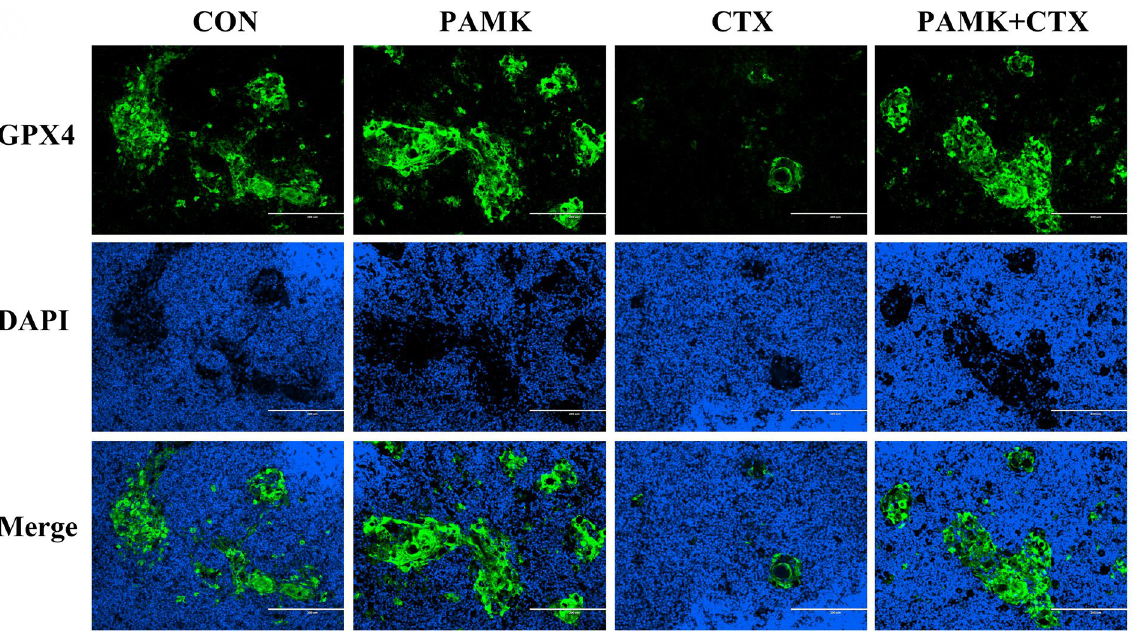
Figure 4. Effects of PAMK on the protein expression of GPX4 in thymus treated with CTX. Images of immunofluorescence staining for GPX4. Representative images from experiments with similar results are shown (scale bar = 200 µ m). n =